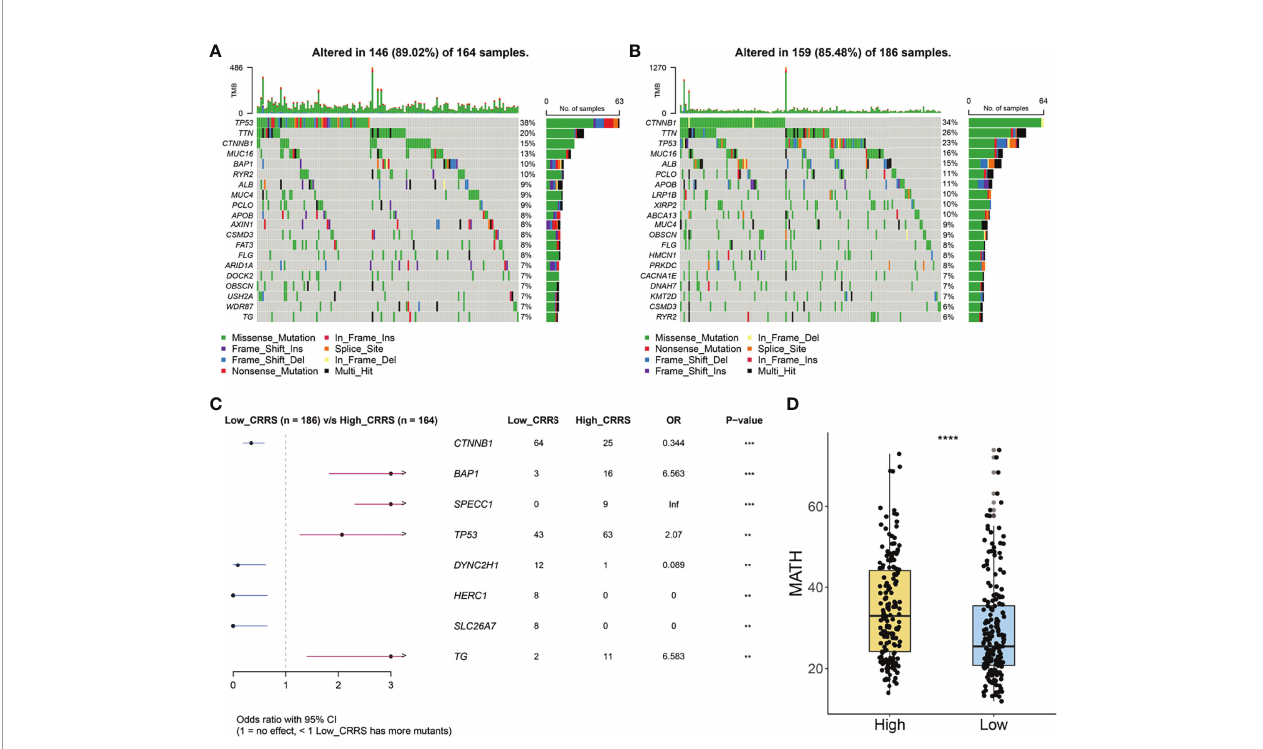
FIGURE 5 | Mutation signatures of CRRS-based HCC groups. (A, B) Oncoplots of the mutated genes in the HCC patients from high-CRRS (A) and low-CRRS (B) subgroups. The mutation types of genes were marked by different colors. (C) Forest plot of the differentially mutated genes between HCC patients from high- and low-CRRS subgroups. (D) Box and dot plot showing the MATH scores of HCC patients from high- and low-CRRS subgroups. Wilcoxon test was used for data analyses. The p values were shown as ****p <